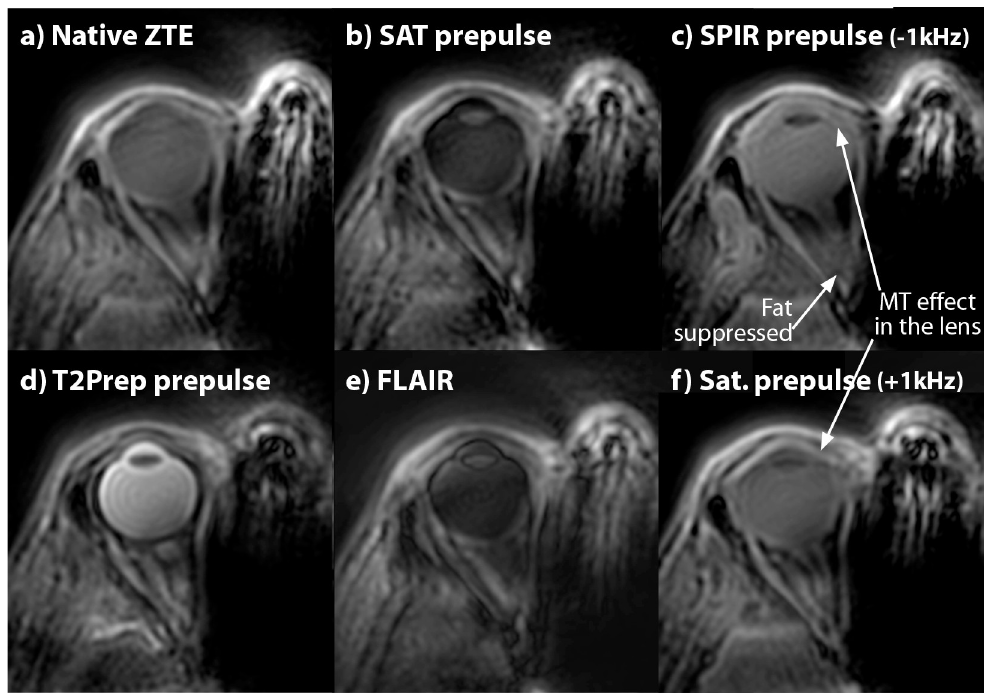
Fig 2. Magnetization-prepared eye ZTE imaging. One selected reformatted slice from the 3D data sets of a healthy volunteer. (a) native ZTE. The eye and parts of the bony structures (especially in the nose area) are visible. Due to the short TE and the low flip angle, the overall contrast is low. (b) A SAT pre-pulse inverts the contrast between eyeball and lens. (c) Fat suppressed (SPIR) ZTE showing improved contrast in the eye and around the nerve and the lens is now visible. (d) T 2 - prepared shows the highest contrast of all sequences. (e) FLAIR-ZTE contrast has low signal from the vitreous body and high signal from the lens and sclera. (f) ZTE image like in (c) but applying the fat saturation RF pulse symmetrically on the other side of the water resonance. This shows no fat suppression but slight contrast in the lens, indicating MTC effect caused by saturating bound water protons.